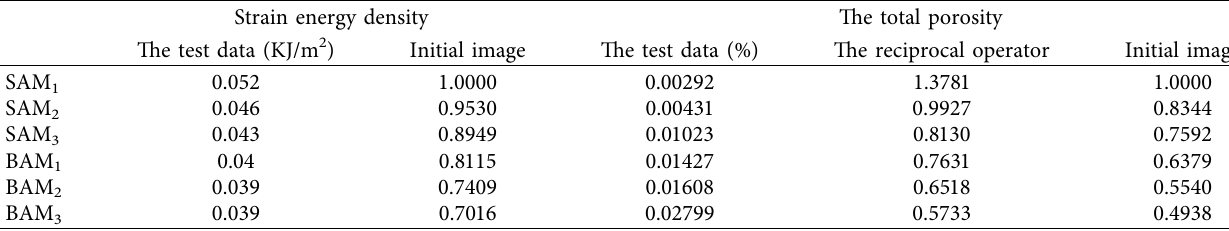
Table 9: Initial evaluating operator of SAM and